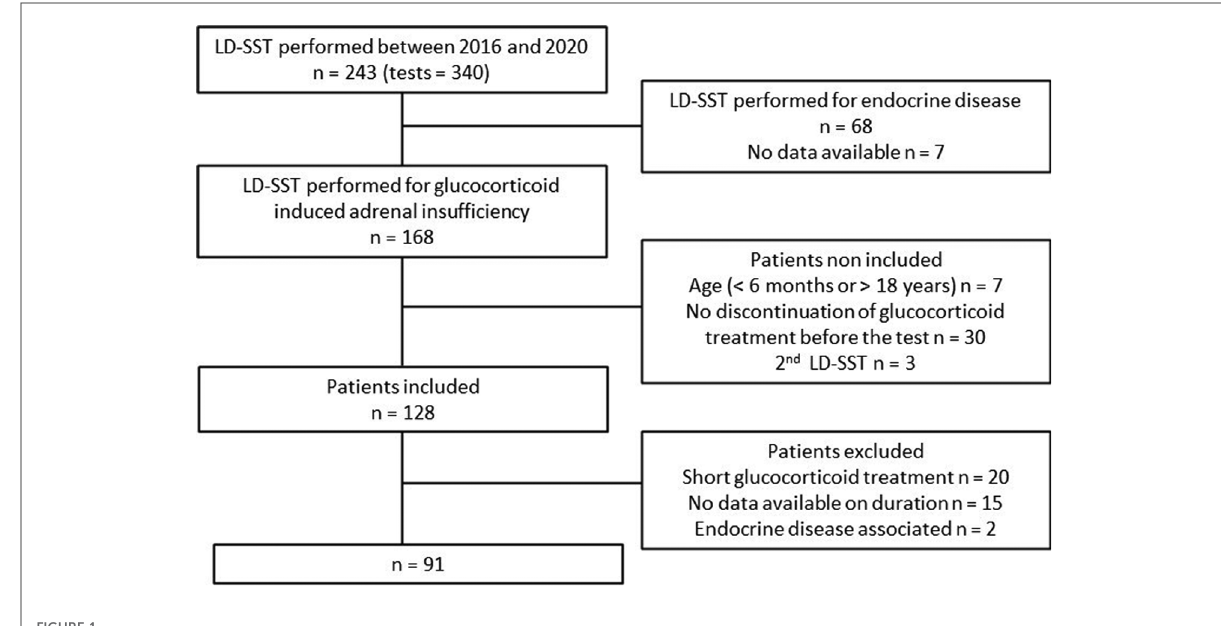
FIGURE 1 Flow chart of the